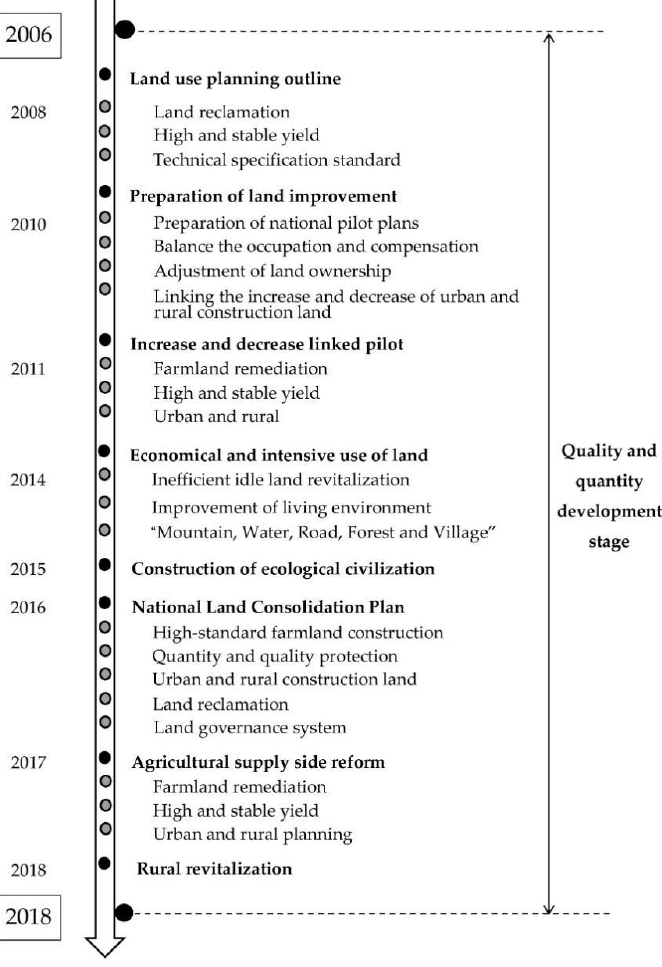
Figure 4. Schematic diagram showing development in the quality and quantity assurance stage.